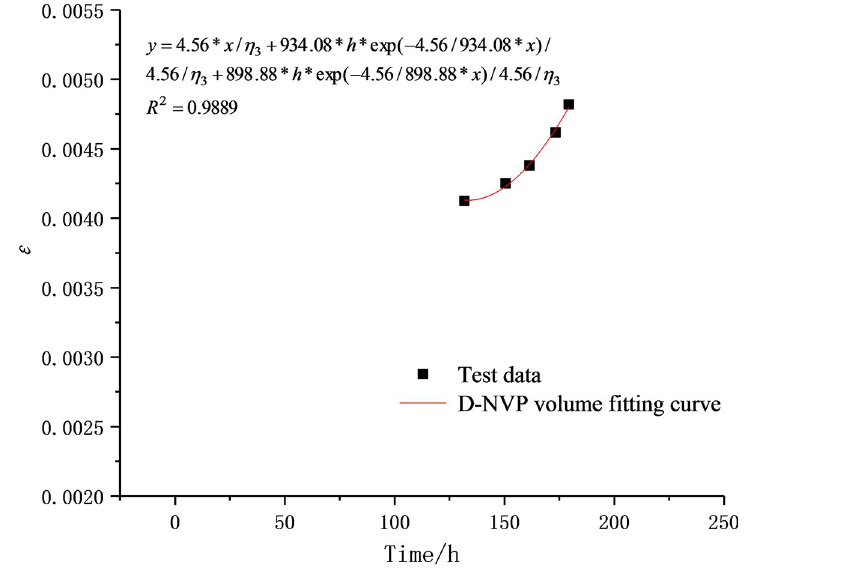
Fig 10. Fitting curve in unsteady creep stage.